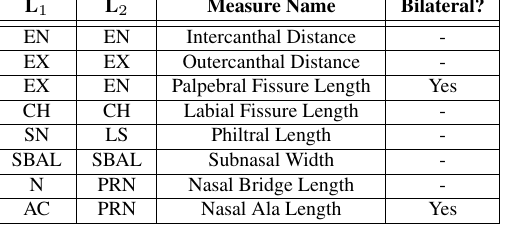
Table 1. The inter-landmark distance measures.